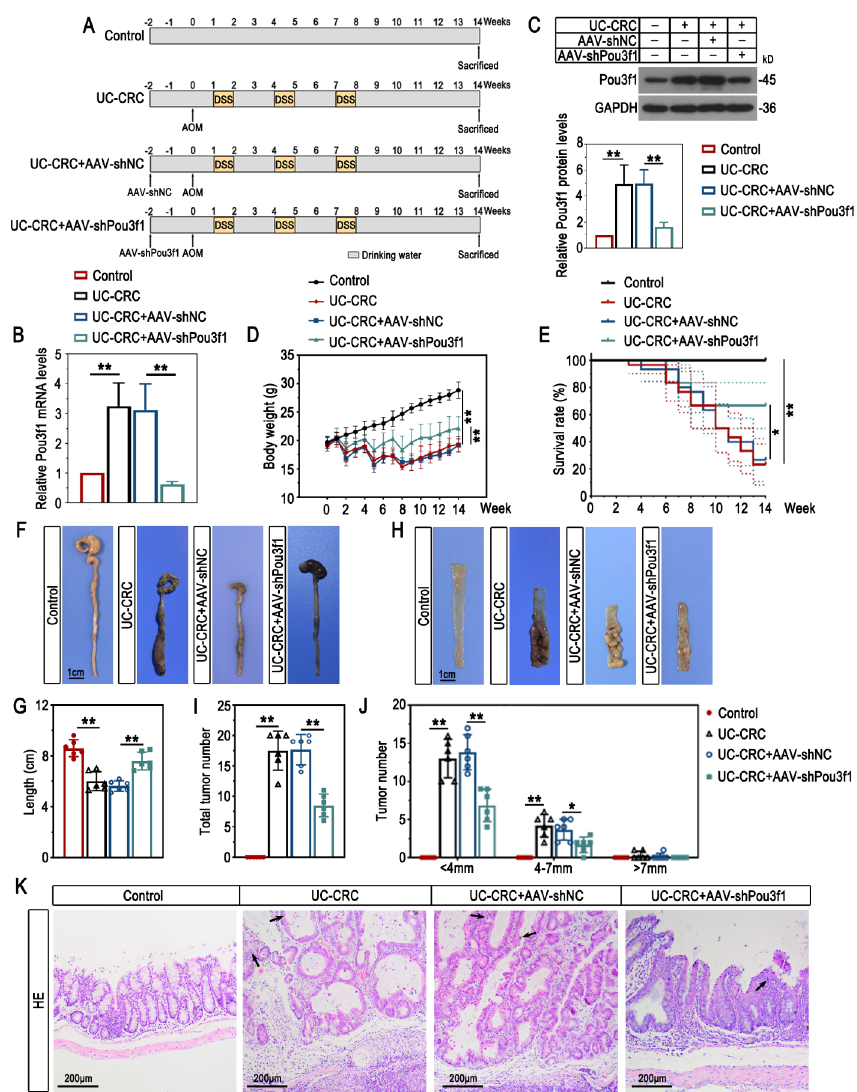
Fig. 5 Pou3f1 knockdown protected against mucosal injury and colon tumorigenesis of UC-CRC mice. (A) The schematic diagram for animal model protocols. (B-C) The mRNA and protein levels of Pou3f1 in colons were mea- sured by qPCR and Western blot. (D-E) The body weight and survival status of mice were recorded weekly. (F-G) The colon length was recorded. (H-J) Representative microscopic images of colon tumors. Total tumor number and the number of tumors with different diameters were counted. (K) Representative images of HE staining for colon tumors. The arrows indicated tumors. Data were from n = 6 mice per group for (B-D) and (F-K); n = 30 mice per group for (E). Values were mean ± SD. *, p <0.05; **, p <